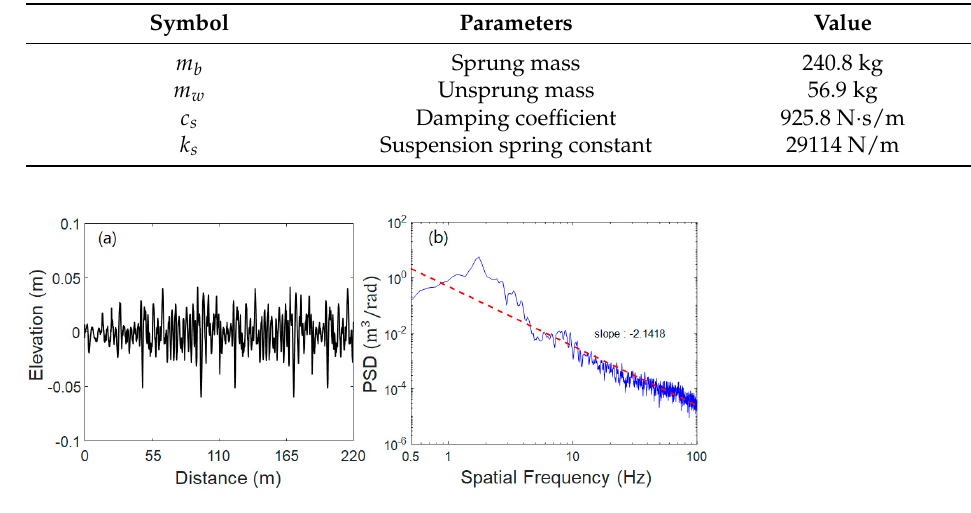
Figure 5. Unknown road roughness input for simulation; ( a ) measured road roughness at a vehicle speed of 20 km/h for 40 s and ( b ) its power spectral density function.